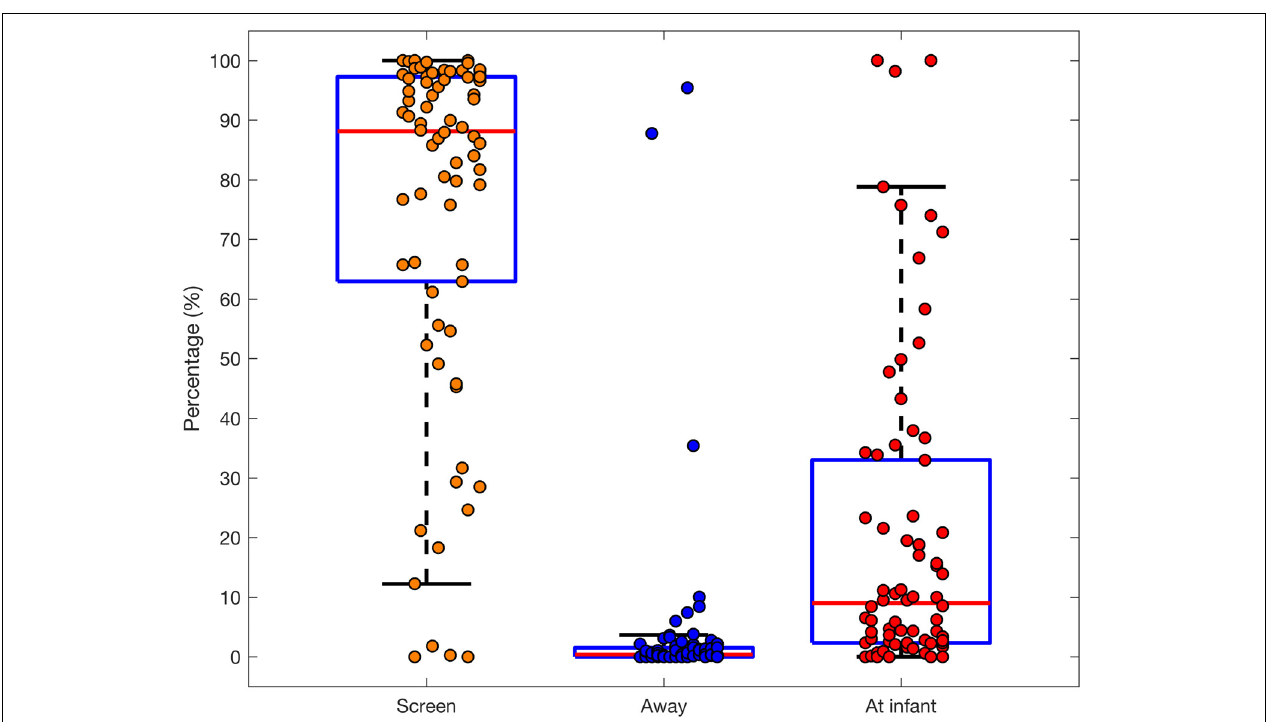
FIGURE 4 | Boxplot with overlaid dots (individual participants) representing the total duration of the parent looking at the screen, away from it or at the infant (only parents with infant on a lap, n =